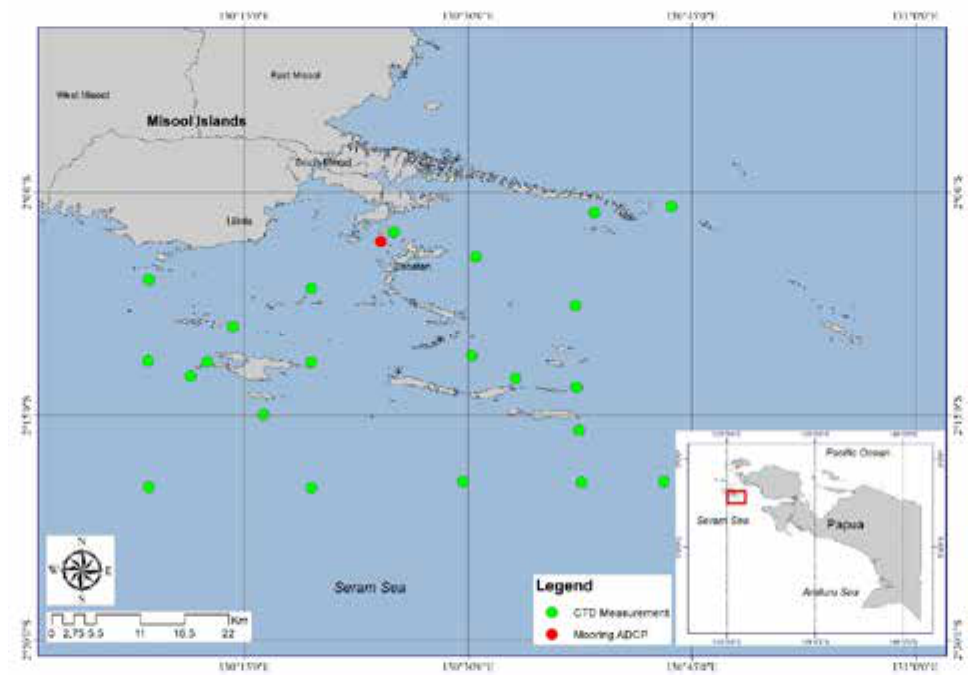
Fig. 1: Geographic location of the study area and station sampling in Misool, West Papua, Indonesia